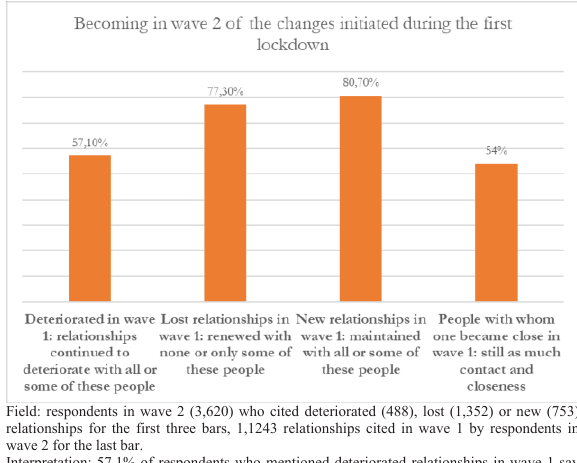
Figure 1 . Lasting effects of lockdown relational